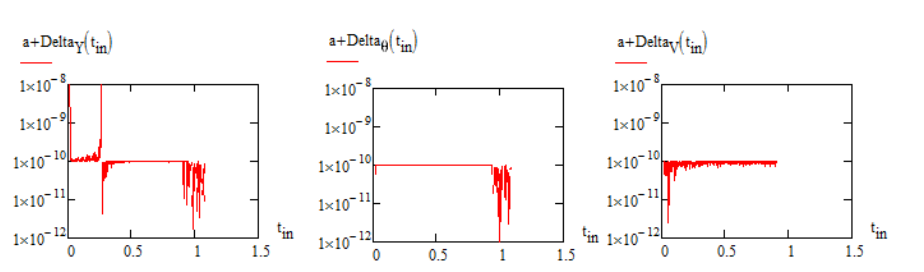
Figure 8 – A visual representation of the relative error of the right and left parts of differential